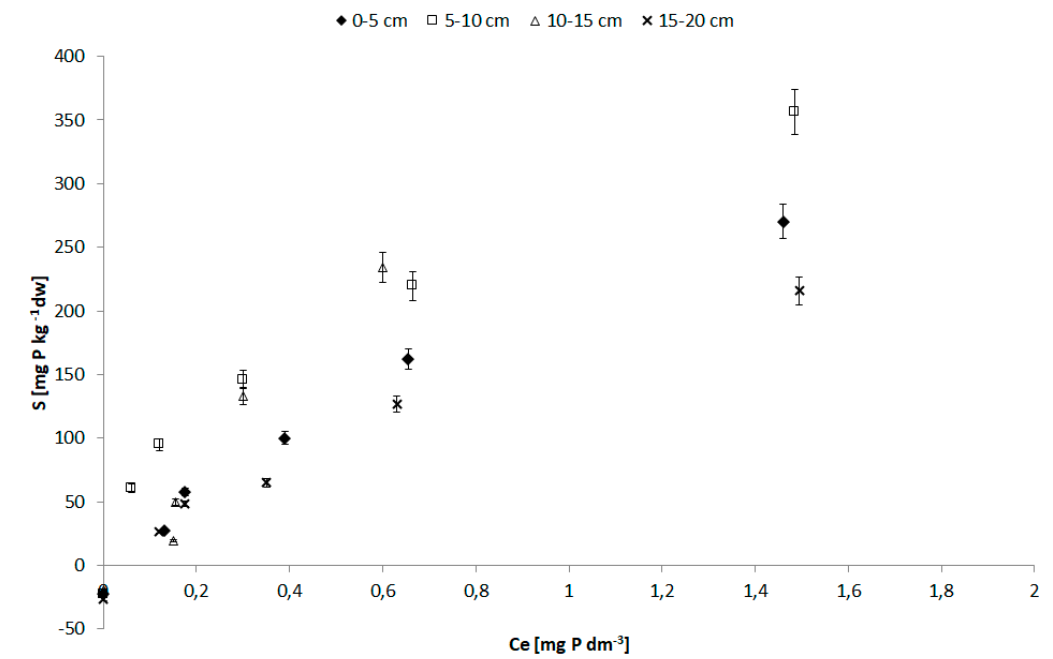
Figure 3. The P adsorption isotherms for sediment taken at St. 2.